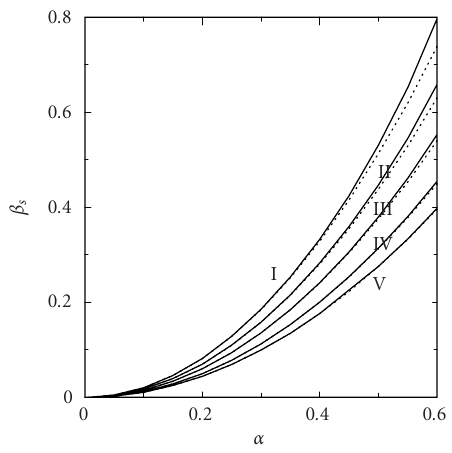
Figure 3.2. The variation of the smaller root β s of (3.10) as a function of the parameter α for var- ious values of the nonintegrability parameter ν . Since λ = 1, these states are unstaggered stationary localized states. Curve I: ν = 1 . 05, curve II: ν = 0 . 75, curve III: ν = 0 . 5, curve IV: ν = 0 . 25, and curve V: ν = 0 . 10. Each curve is associated with a dotted curve which shows the variation of α 2 (1+ ν λ ) as a function of α for the corresponding value of ν .